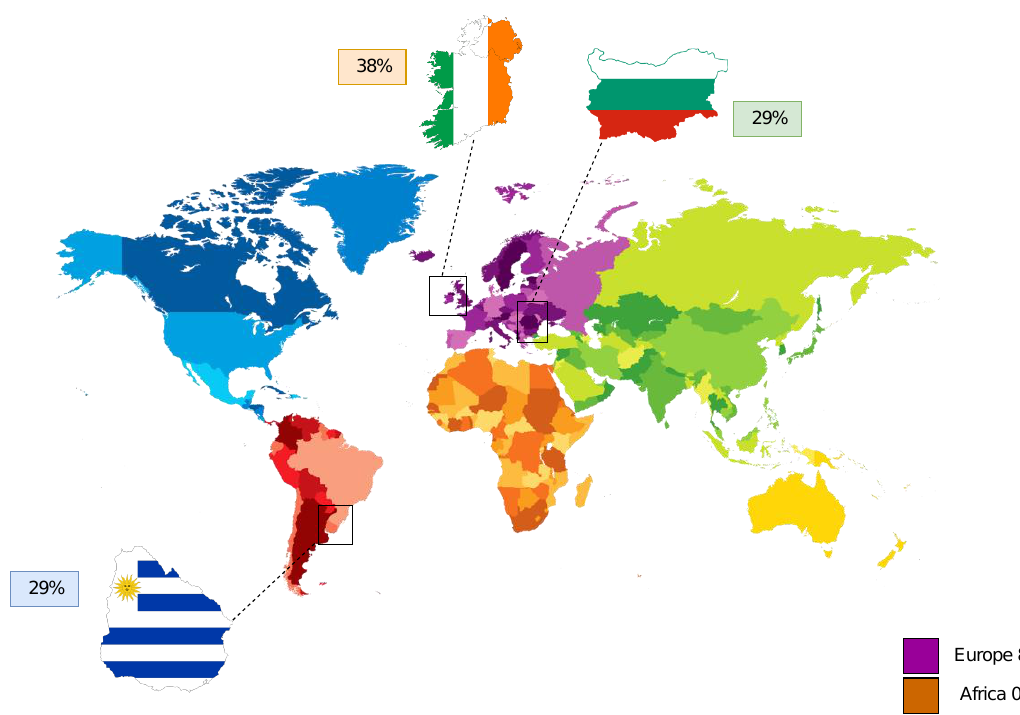
Figure 3. Regional prevalence of cigarette smoking during pregnancy in Europe and Africa, as well as the top three countries, Ireland, Uruguay, and Bulgaria, with the highest known incidence worldwide.